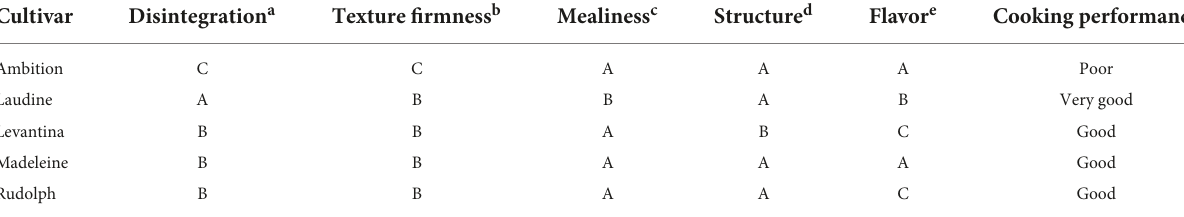
TABLE 2 Values assigned to each parameter measured for cultivars with cooking aptitude.